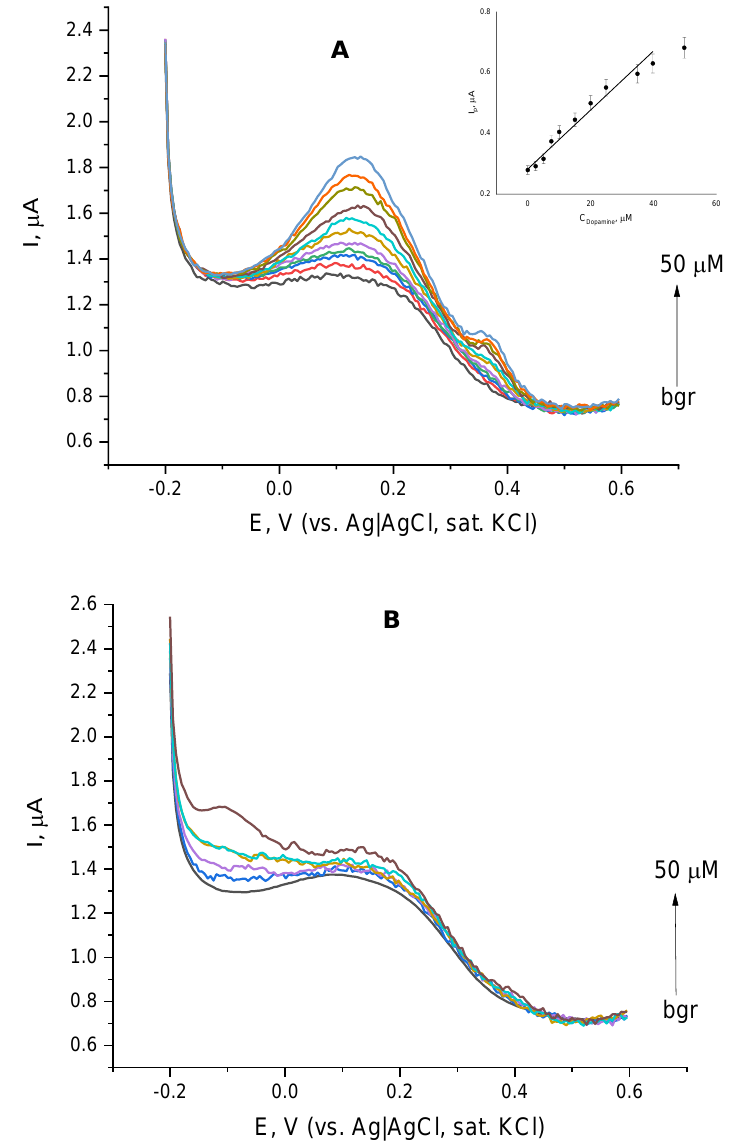
Figure 4. Differential pulse voltammograms of laccase immobilized on cystamine-modified gold in the presence of dopamine ( A ) and L-epinephrine ( B ) with concentrations ranging from 0 to 50 µ M; background electrolyte—constantly aerated 0.05 M citrate buffer containing 0.1 M NaClO 4 , pH = 4.0. Inset of ( A ) dependence of the DPV peak height on dopamine concentration.